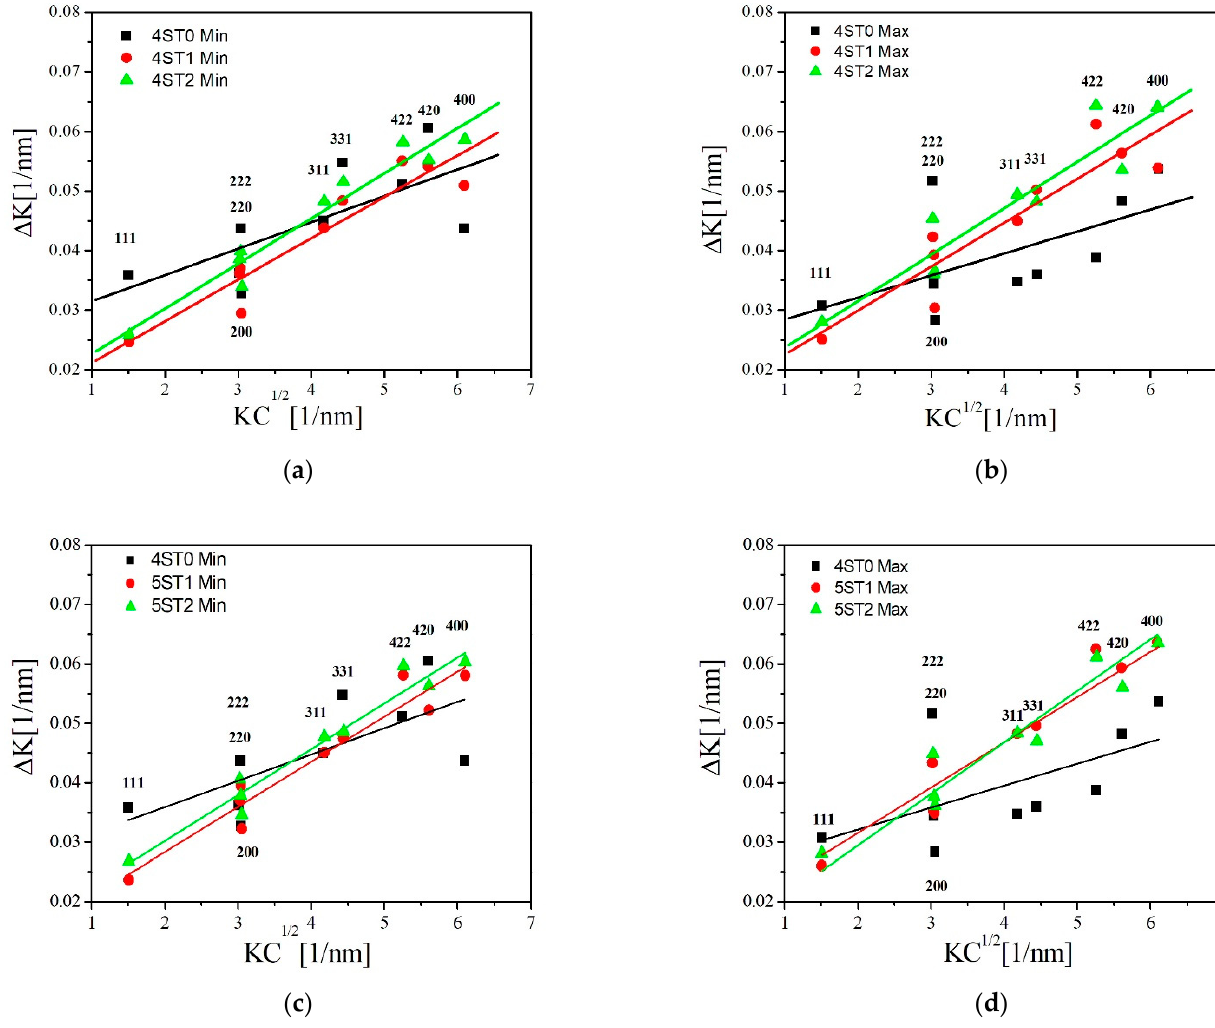
Figure 16. Modified Williamson–Hall plots for ( a ) 4ST Min., ( b ) 4ST Max., ( c ) 5ST Min. and ( d ) 5ST Max.